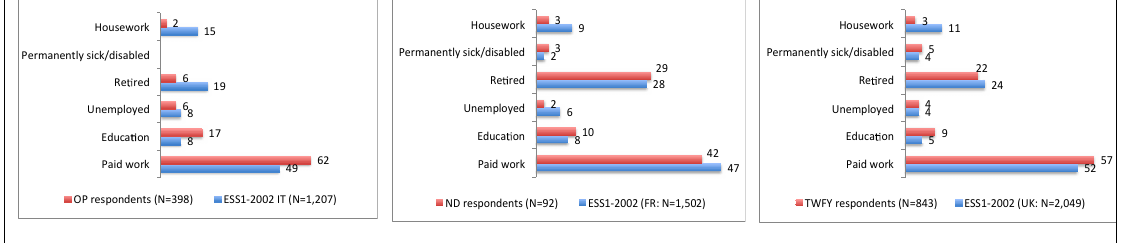
Figure 2. Main activity during the last seven days (%) (Author’s surveys 2011; Escher 2011; ESS1- 2002)